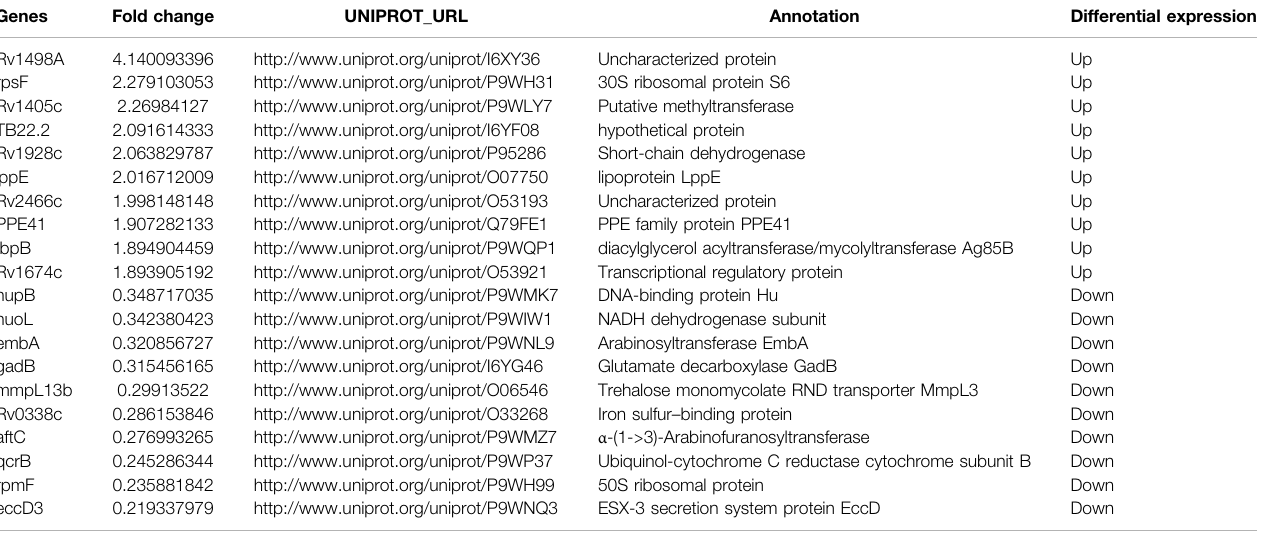
TABLE 5 | The top10 differentially expressed proteins between intracellular M.tb and extracellular M.tb. Genes Fold change Annotation Differential